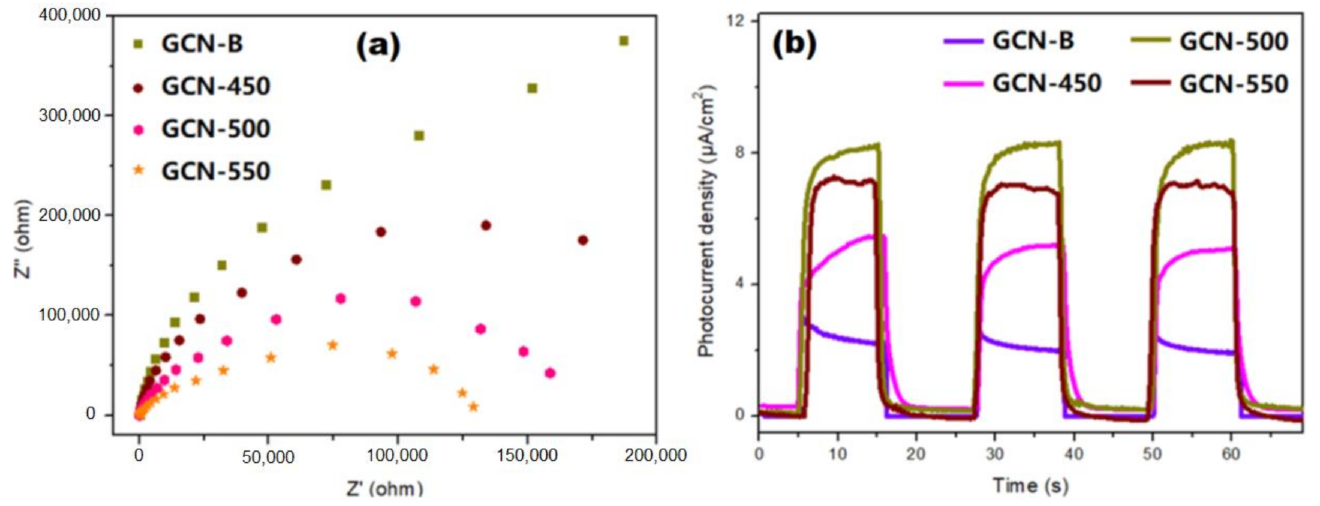
Figure 11. ( a ) EIS changes of GCN-B and GCNs that recalcined at different temperatures, and ( b ) transient photocurrent responses of GCN